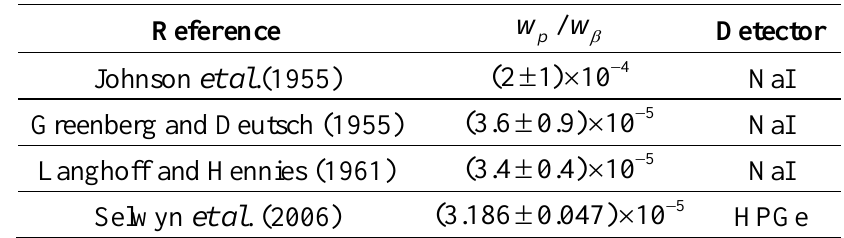
Table 1. Probability of pair creation per beta decay measured in earlier and more recent literature studies.